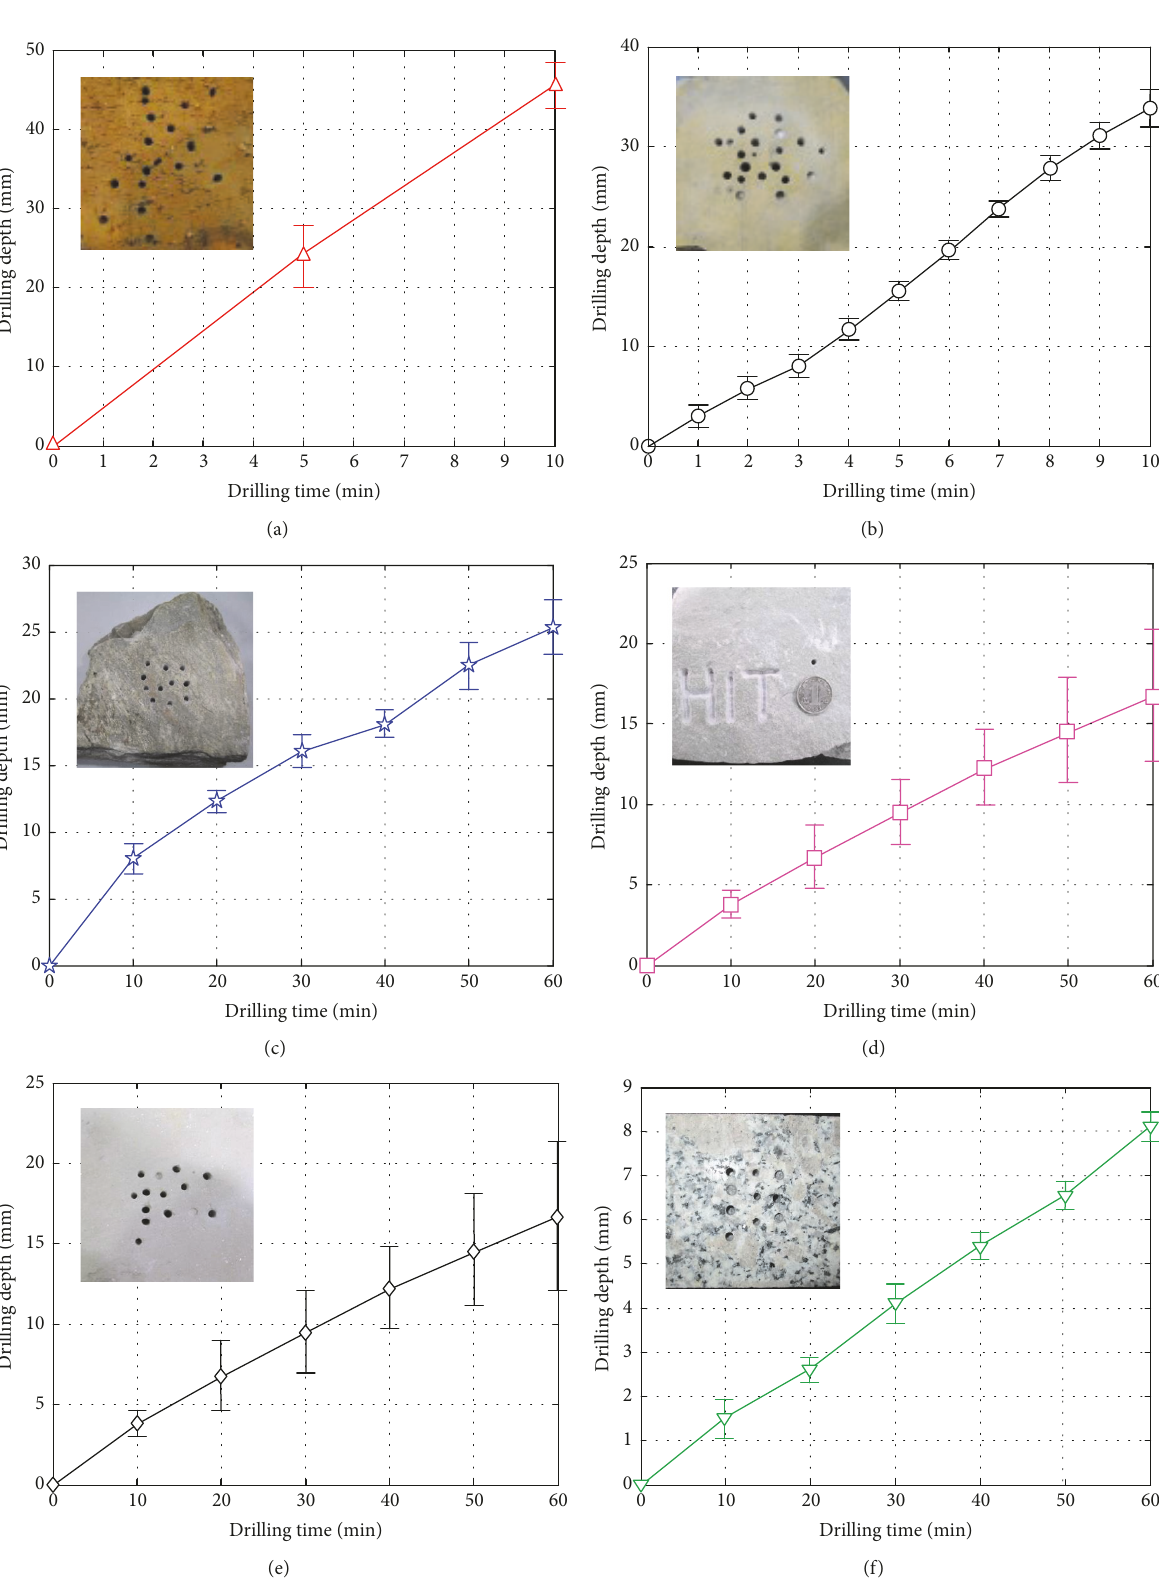
Figure 13: The drilling experiment results of the rocks with different hardness grades. (a) Red brick. (b) Sandstone. (c) Melaleuca stone. (d) Marble. (e) Green rock. (f)